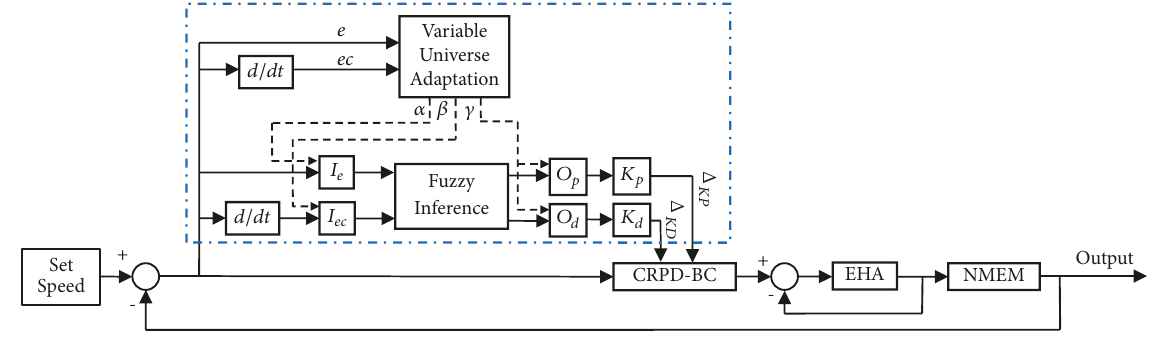
Figure 1: The control flow chart of robust fuzzy PD control of marine engine speed regulation.